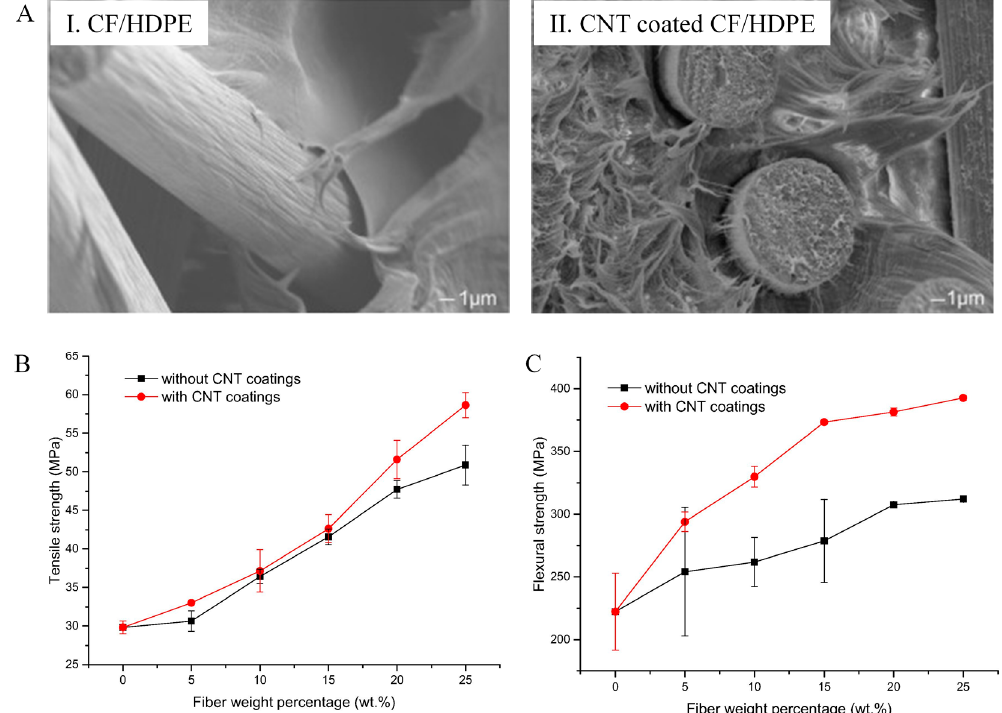
Figure 7. Effect of CNT coating on morphological and mechanical properties of CF reinforced HDPE composites: ( A ) Fracture morphologies: I. Neat CF/HDPE composite; II. CNT coated CF/HDPE composite. ( B ) Comparison of tensile strength. ( C ) Comparison of flexural properties. Reprinted with permission from ref. [32], Copyright 2019 Elsevier Ltd.